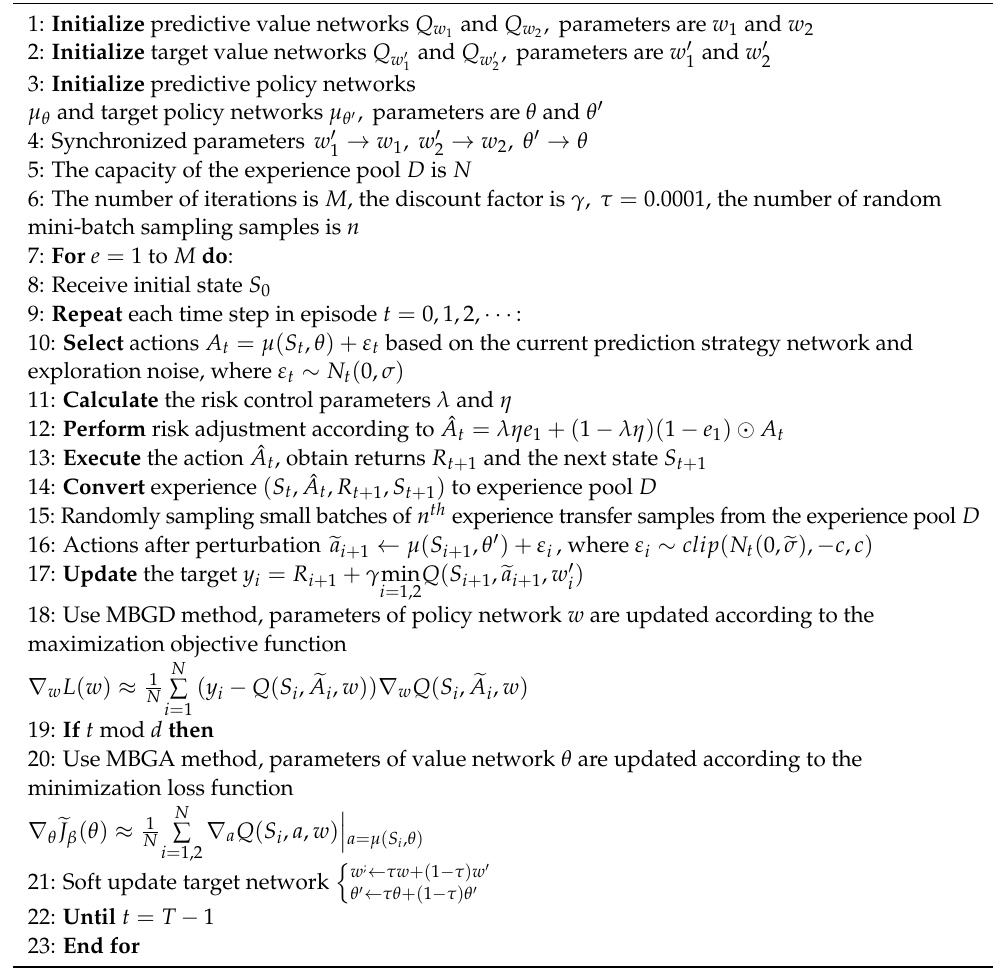
Algorithm 1 LSTR–TD3